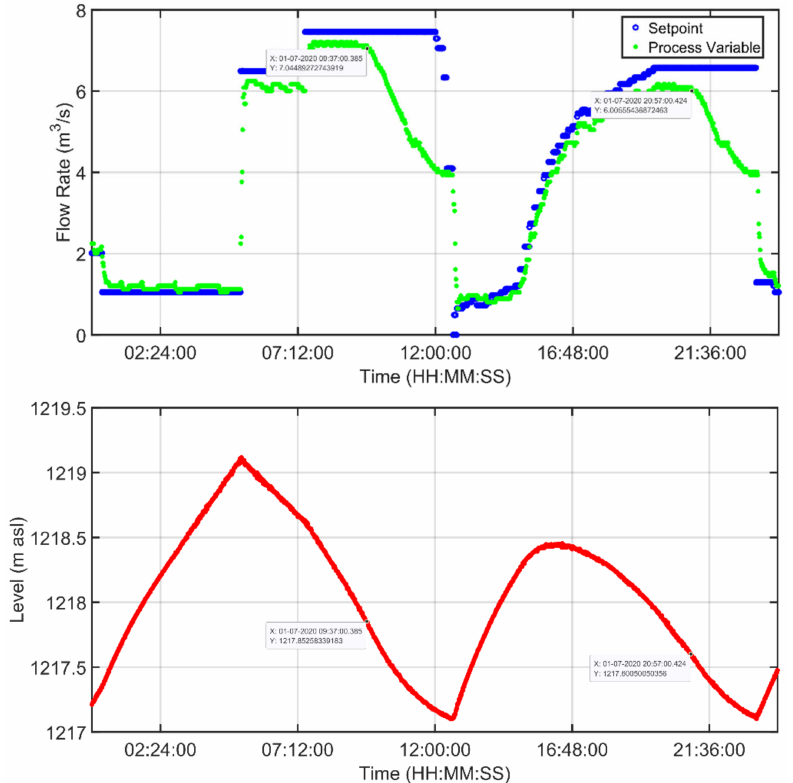
Figure 10. Data analysis results: Beikircher regulation gate control loop variables and upstream reservoir